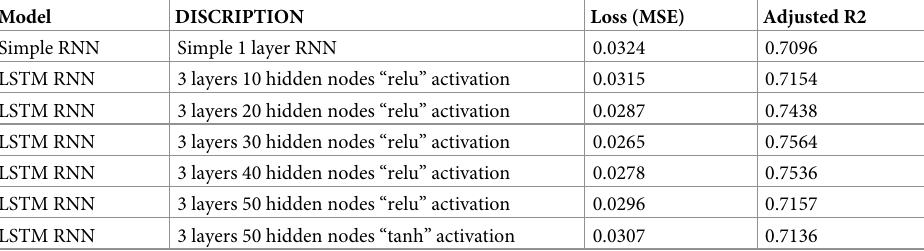
Table 5. Summary of model fine-tuning for travel